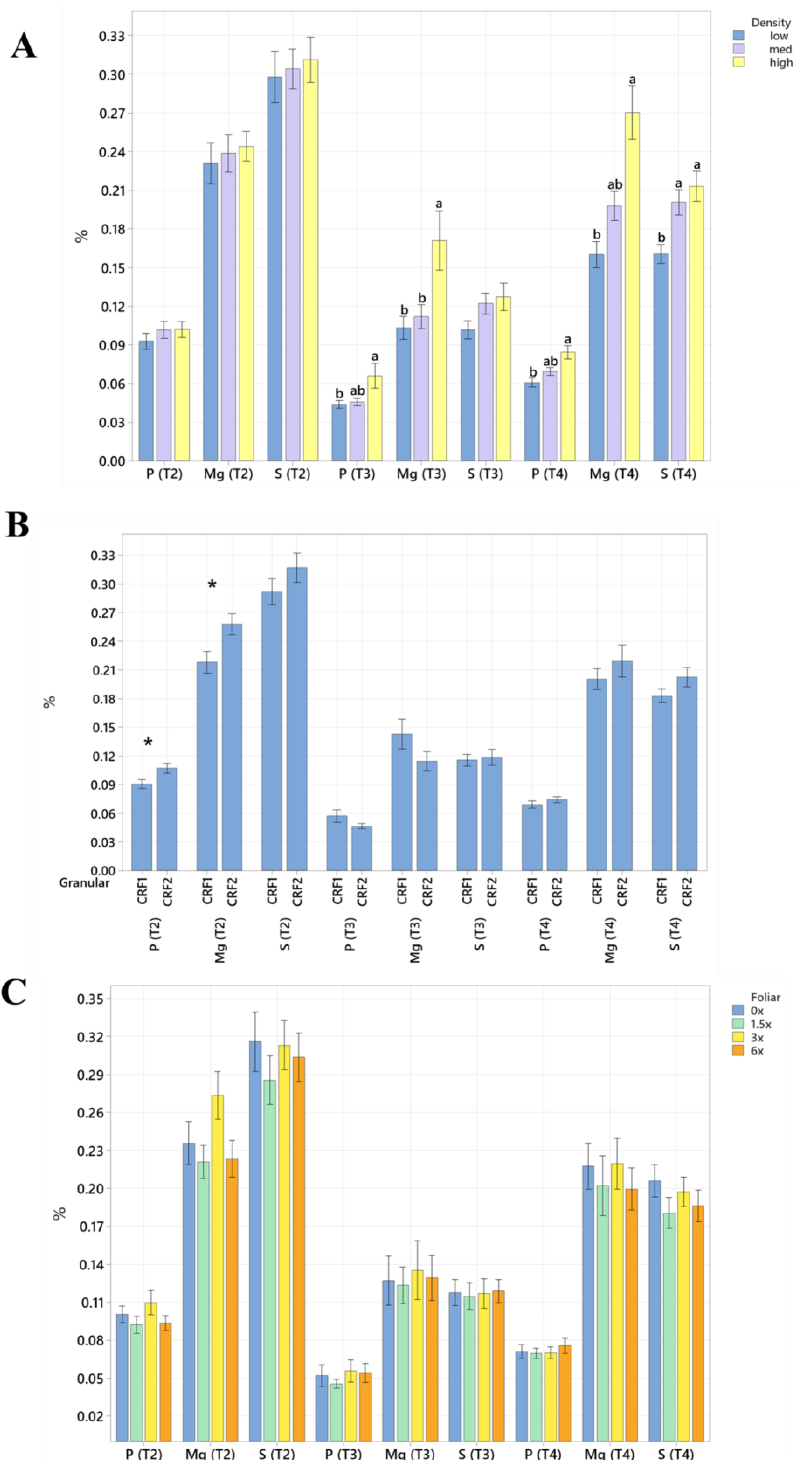
Figure 6. Root P, Mg and S concentrations of ‘Ray Ruby’ grapefruit grafted on ‘Kuharske’ citrange planted in flatwood soils located in Fort Pierce, FL, USA. Graphs indicate response to ( A ) planting density, ( B ) ground-applied fertilizer and (C) foliar fertilizer treatments during May 2021 (T2), September 2021 (T3) and January 2022 (T4). Bars are ± standard deviation of the mean. Treatments with * and different letters were considered to be significantly different ( p < 0.05).